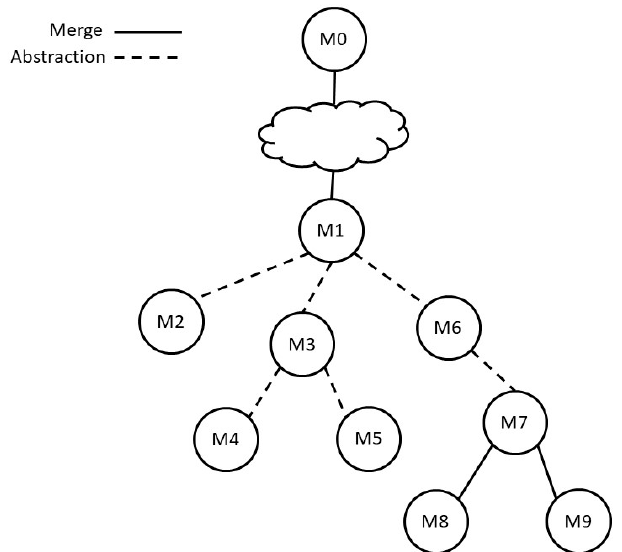
Figure 15. Process model in Figure 13 resulting from the selective merging of Monitoring.